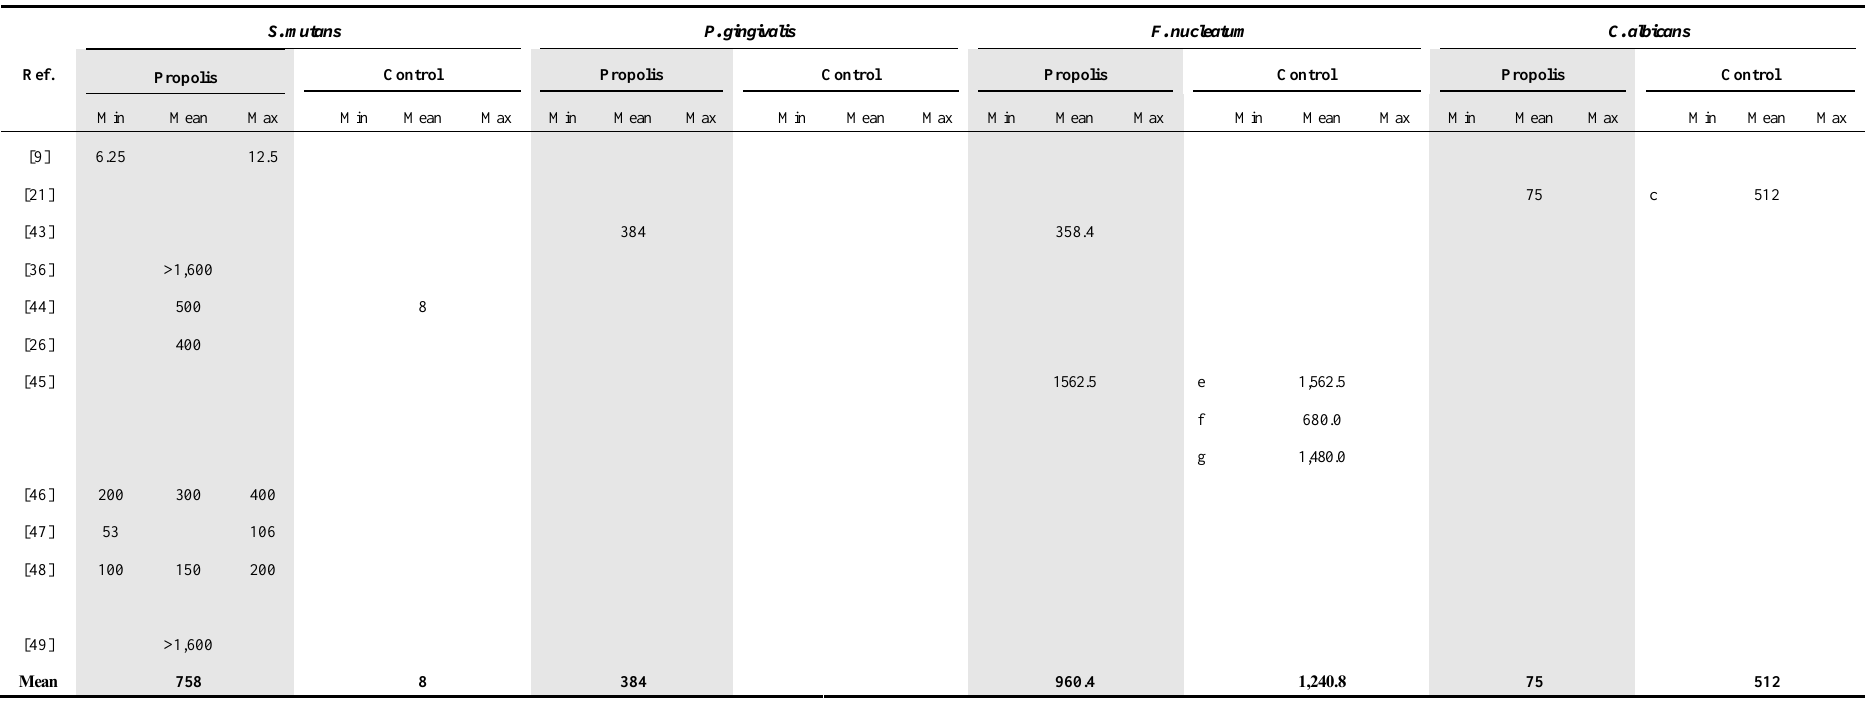
Table 2. MBC (minimal bactericidal concentration; µg/mL) of propolis and control compounds (indicated with different superscript letters).